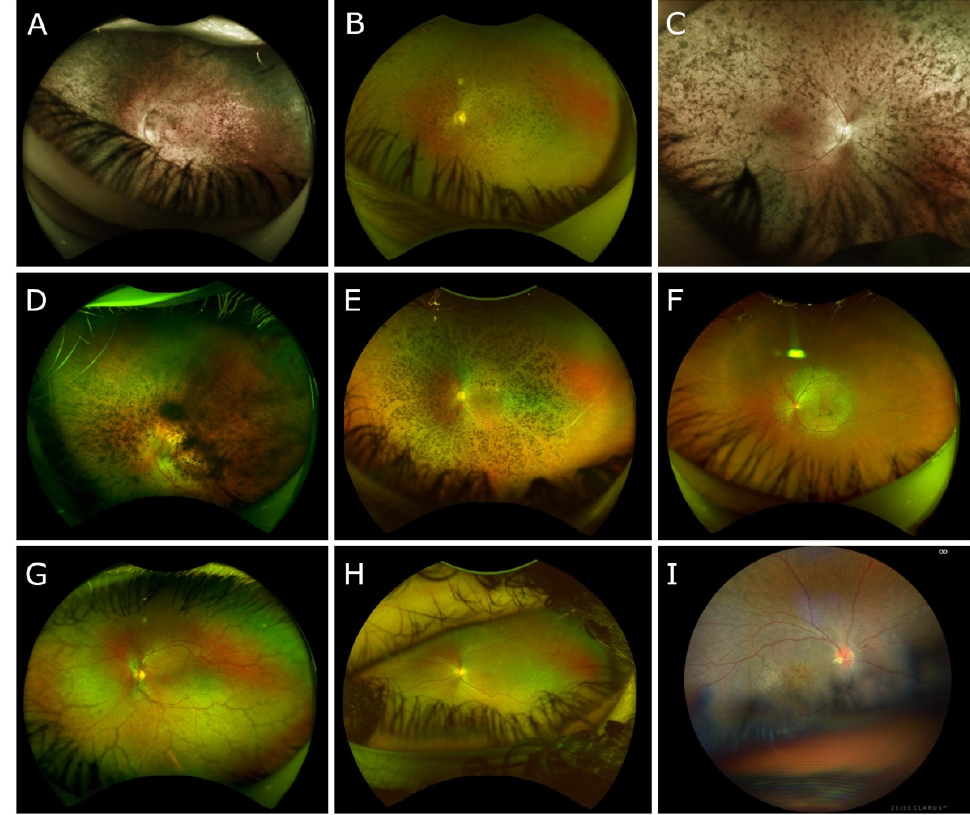
Figure 1. Color fundus imaging for nine patients with at least one confirmed mutation among the ten most prevalent mutations in CRB1 . ( A – E ) Patients 1, 3, 4, 5, and 7, respectively, with ages ranging from 20 to 49 years old, demonstrated extensive intraretinal pigment migration 360-degrees throughout the periphery with relative para-arteriolar sparing. ( F ) Patient 6 presented with significant macular atrophy extending beyond the arcades with central pigmentary changes. There is no peripheral pigment migration. ( G – I ) Patients 2, 8, and 9, respectively, who are under the age of 10, demonstrated rare pigment migration scattered throughout the posterior pole and peripheral retina.